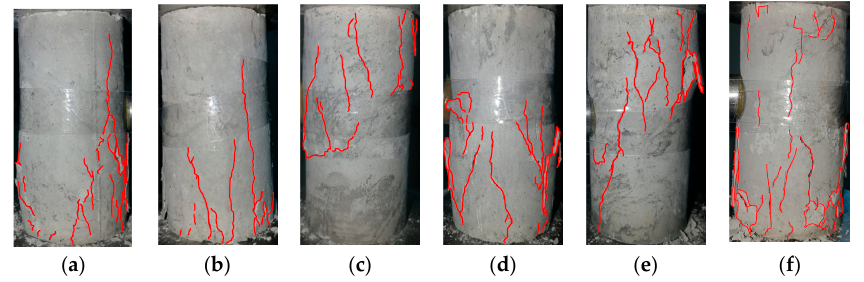
Figure 7. Failure characteristics of CGFB samples. ( a ) A-1; ( b ) B-2; ( c ) C-2; ( d ) D-3; ( e ) E-3; ( f ) F-3. A single stress–strain curve cannot reflect the development process, but the failure degree of CGFB samples with different amounts of kaolin addition can be revealed in detail by analyzing the AE Ra and cumulative Ra value. The different characteristics of tensile failure and shear failure can also be understood in detail. The Ra value of the AE is the ratio of the rise time to amplitude, which is an important index for determining the fracture mode. Shiotani et al. [35] calculated the Ra value of rock under bending and shear tests and concluded that a low Ra value corresponds to a shear crack, while a high Ra value corresponds to a tensile crack. In Figure 8, the relationship between axial stress and cumulative RA value over time during failure of CGFB samples with different kaolin contents is shown to reveal the fail- ure characteristics. It can be seen that when the CGFB samples without kaolin fail, the initial Ra value is at a low level, and the cumulative Ra value increases slowly, which indicates the occurrence of shear failure. Near peak stress, the Ra value suddenly in- creases, and the cumulative Ra value increases rapidly. This phenomenon can be under- stood as the point when the CGFB samples without kaolin start getting compacted under the action of the vertical load, resulting in transverse tensile stress. As alluded to earlier, due to existence of gangue particles and a large number of holes, microcracks, and other defects in CGFB samples, their internal structure is under uneven stress, and the effective bearing area reduces, resulting in shear failure of mutual dislocation initially. With the gradual increase in vertical load, friction between a large number of holes and microcracks also increases, which inhibits mutual dislocation, and CGFB samples attain a stable state. As the load continues increasing and becomes higher than the compressive strength of CGFB samples, a crack begins to develop, and the sample finally fractures.